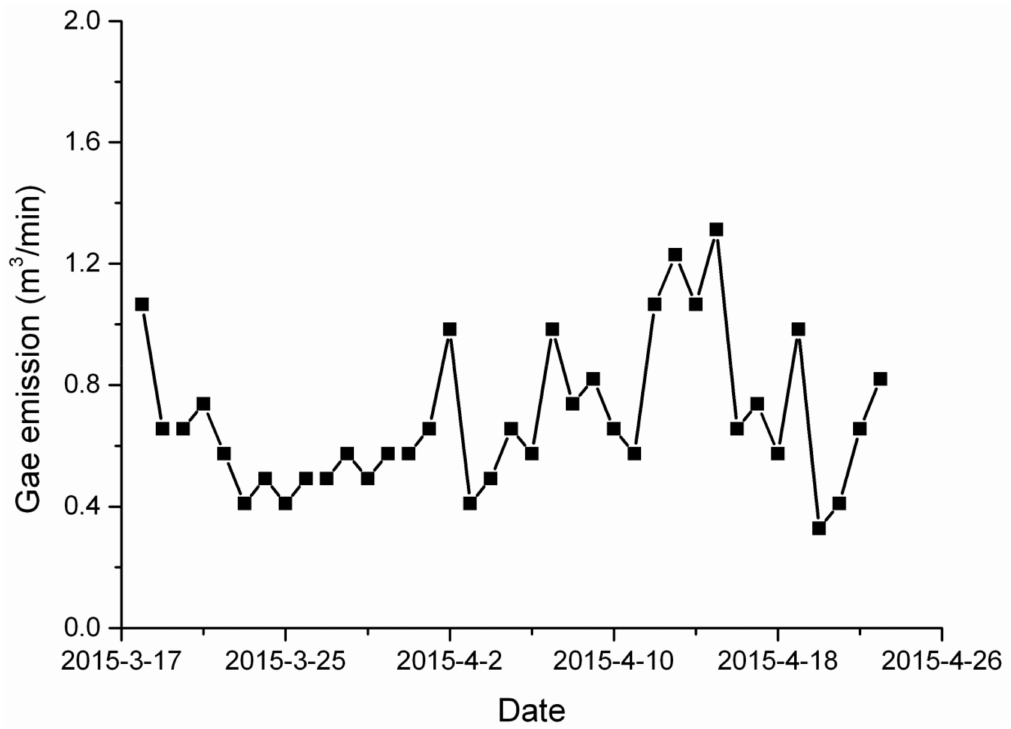
Figure 3. Gas emission from No. 11131 mining